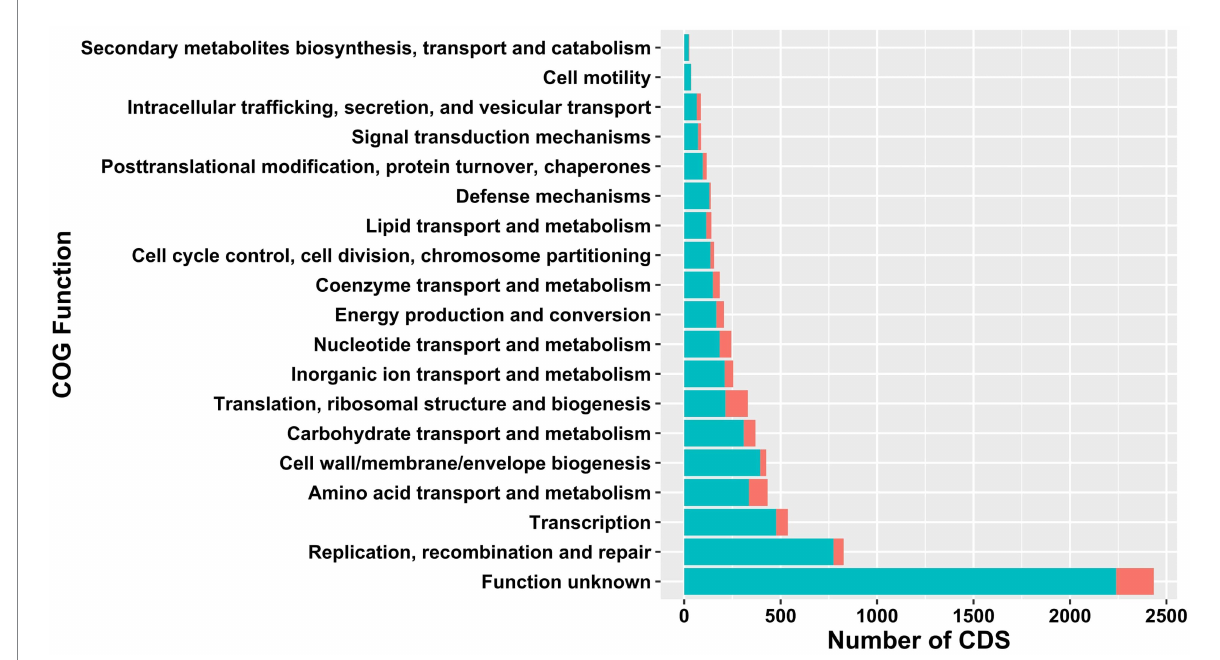
FIGURE 2 Comparison of functional COGs in pan- (light green) and core (red) genome of 38 Ln. pseudomesenteroides